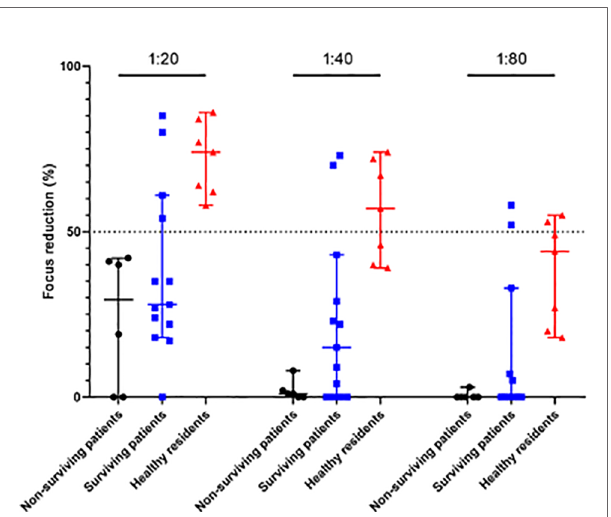
FIGURE 1 | Neutralizing antibody titrations. Neutralizing antibodies to SFTSV were evaluated (FRNT50) in serum samples collected from 6 non-surviving patients, 13 serum samples from 5 surviving patients, and 7 serum samples from 5 healthy residents. Individual samples were serially diluted from 1 ∶ 20 to 1 ∶ 80. Statistically signi fi cant differences were found among surviving patients, non-surviving patients, and healthy residents ( p <0.05 for all dilution